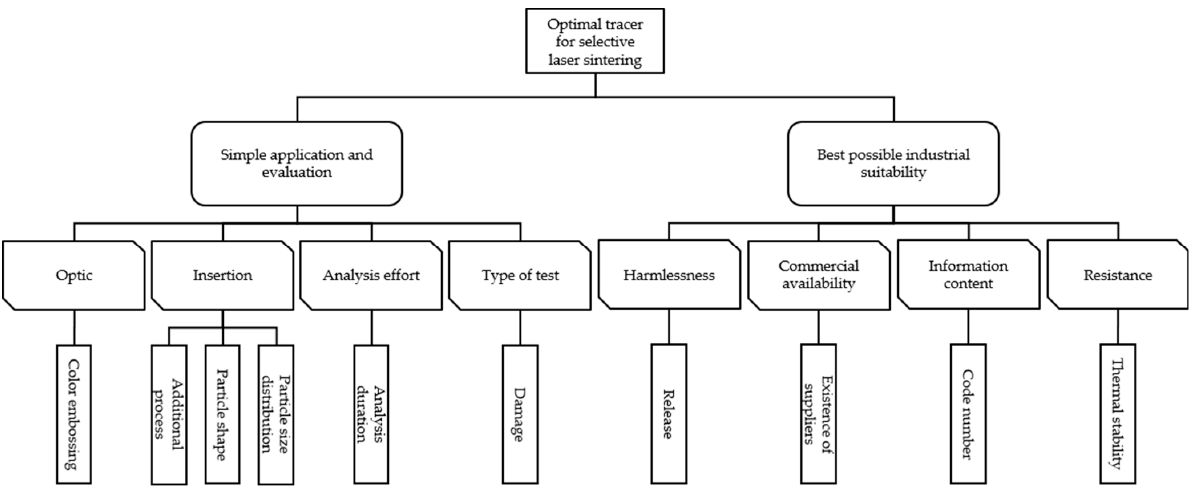
Figure 3. Established hierarchical target system for the present use case. Based on the hierarchical target system (Figure 3) and taking into account the used sinter material, the evaluation points of the individual criteria are obtained (Table 3). Table 3. Assessment points of the individual